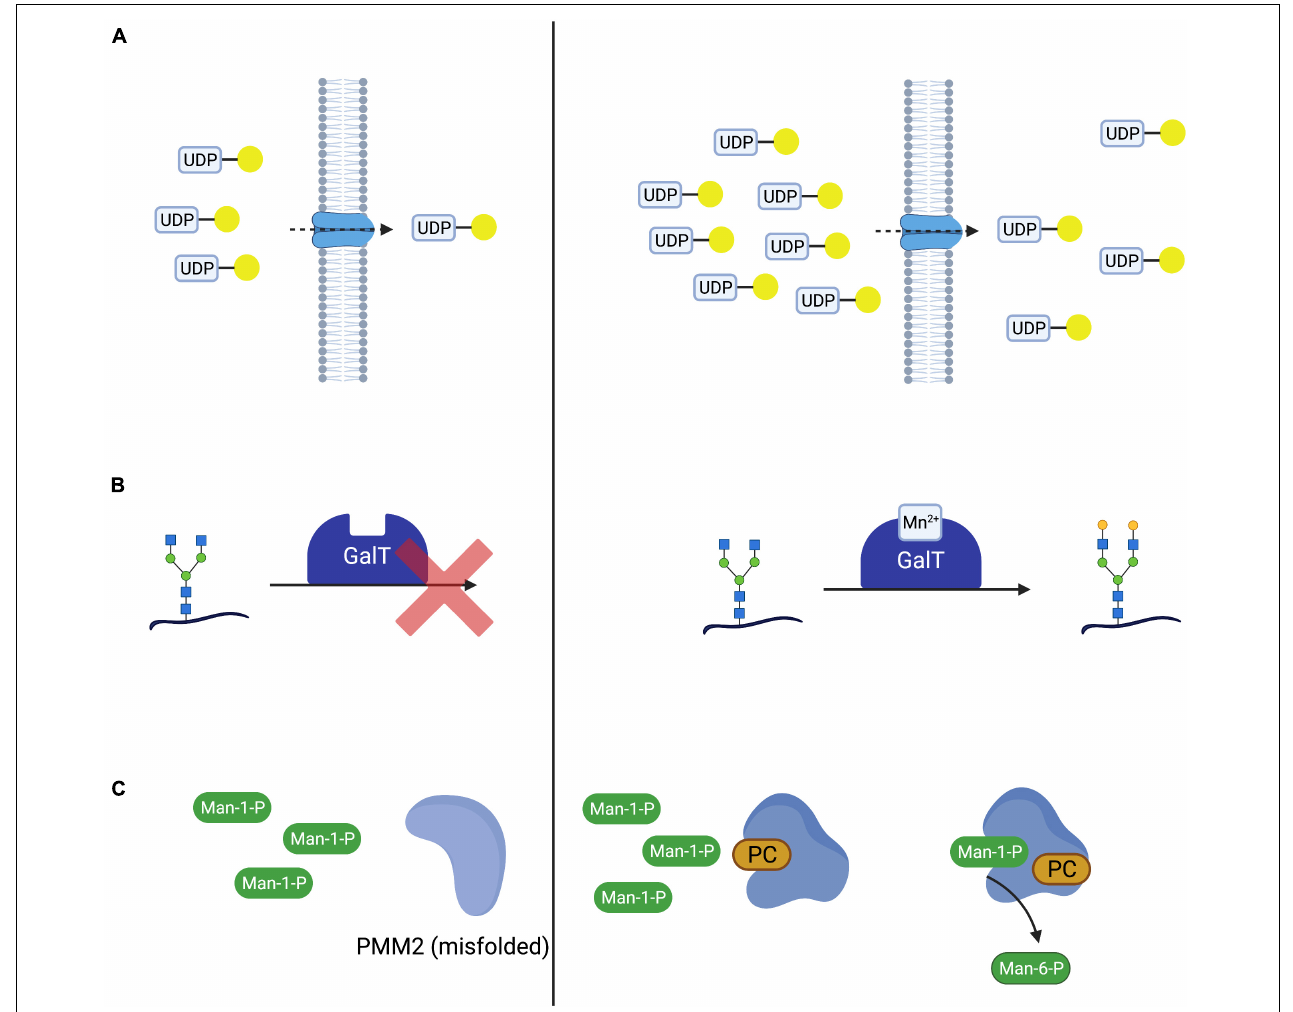
FIGURE 2 | Therapeutic concepts for congenital disorders of glycosylation. (A) Substrate supplementation aims at overcoming the impaired transport process or enzymatic reaction by increasing the concentration of the substrate of the respective reaction. One such treatment is galactose supplementation for SLC35A2-CDG, where oral supplementation of galactose (yellow circle) increases UDP-galactose supplies and thus transport across the defective UDP-galactose transporter SLC35A2. (B) In SLC39A8-CDG, defects in SLC39A8 lead to a deficiency in manganese (Mn 2 + ). Lack of this cofactor impairs the function of galactosyltransferases (GalT). Cofactor supplementation leads to an improved GalT function and thus normalized glycosylation. (C) Mutated and subsequentially misfolded enzymes are either degraded or impaired in function. Specific mutations in PMM2 result in misfolded phosphomannomutase 2 (A) . Pharmacological chaperones (in this case epalrestat) bind and stabilize the affected enzyme, leading to increased enzyme activity and thus improved glycosylation (B)